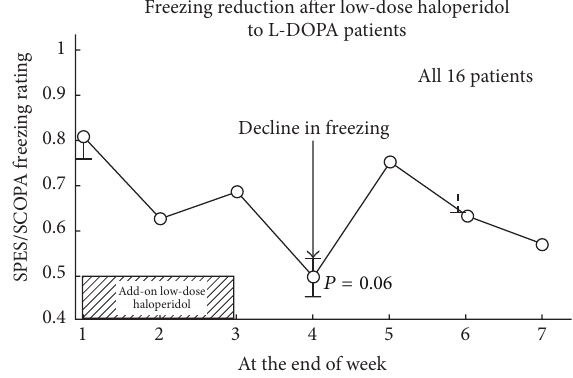
Figure 2: While continuing the daily dose of levodopa, the add-on low dose of 40 𝜇 g haloperidol resulted in lower freezing ratings on the SCOPA